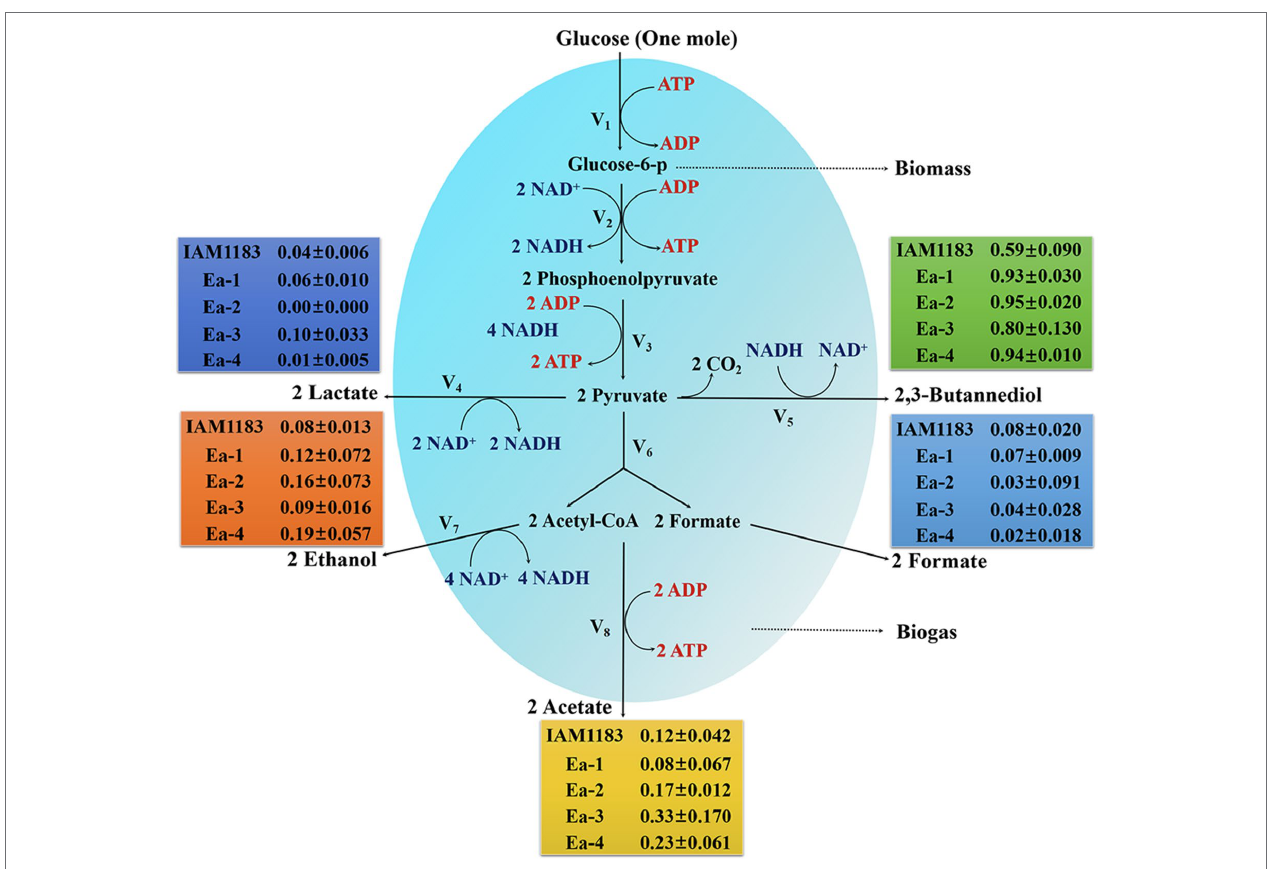
FIGURE 3 | Metabolite profiles of IAM1183 and the mutants Ea-1 to -4 after 20 h of shake-flask cultivation with glucose as carbon source ( n = 3). The data shown in Table 2 were used for the